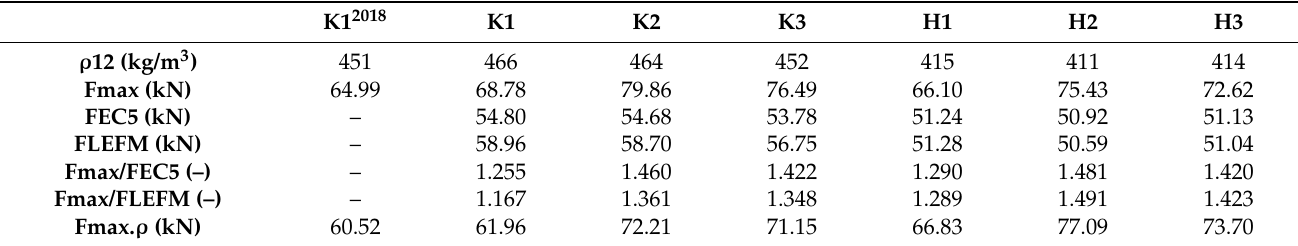
Table 8. Comparison of the results for all types of